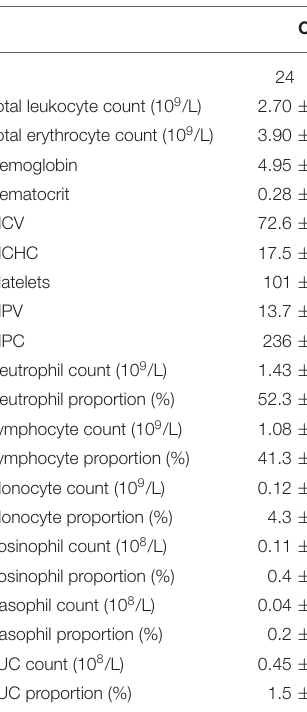
TABLE 5 | Blood cell count parameters a